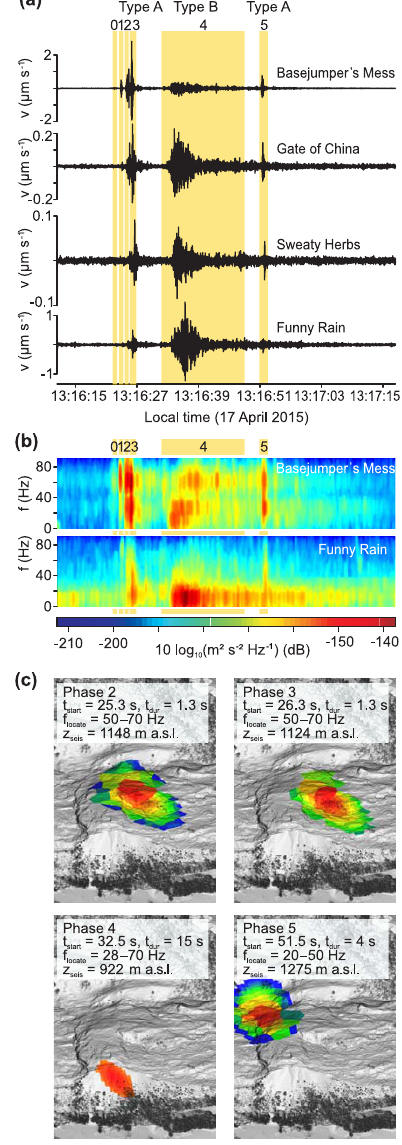
Figure 4. Seismic view of a complex rockfall (event 37). (a) Sig- nal waveforms of the sequence from four seismic stations filtered between 0.5 and 90Hz with four distinct seismic pulses and a longer emergent part. (b) Power spectral density estimates of station “Basejumper’s Mess” and “Funny Rain”. The five distinct events cover different frequency ranges over both time and space. (c) Seis- mic impact location estimates of events 2 to 5 with location poly- gons clipped at the 0.99 quantile for illustrative reasons. The scenes show an oblique aerial view onto the lidar-based surface model of the affected cliff section. Values denote t start start time (second of the UTC time denoted in a ), t dur event duration used as time win- dow for the signal migration approach, f locate frequency range used to filter the data before migration (based on ranges of all stations) and z seis height of location estimate. All times refer to station Base- jumper’s